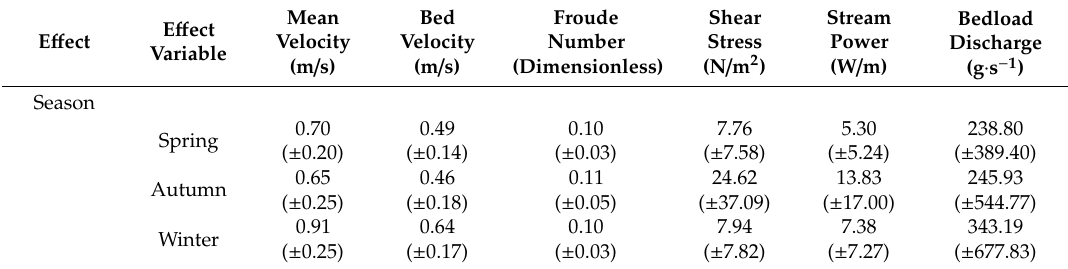
Table 4. Mean values ( ± SD) associated with mussel bed habitat variables by e ff